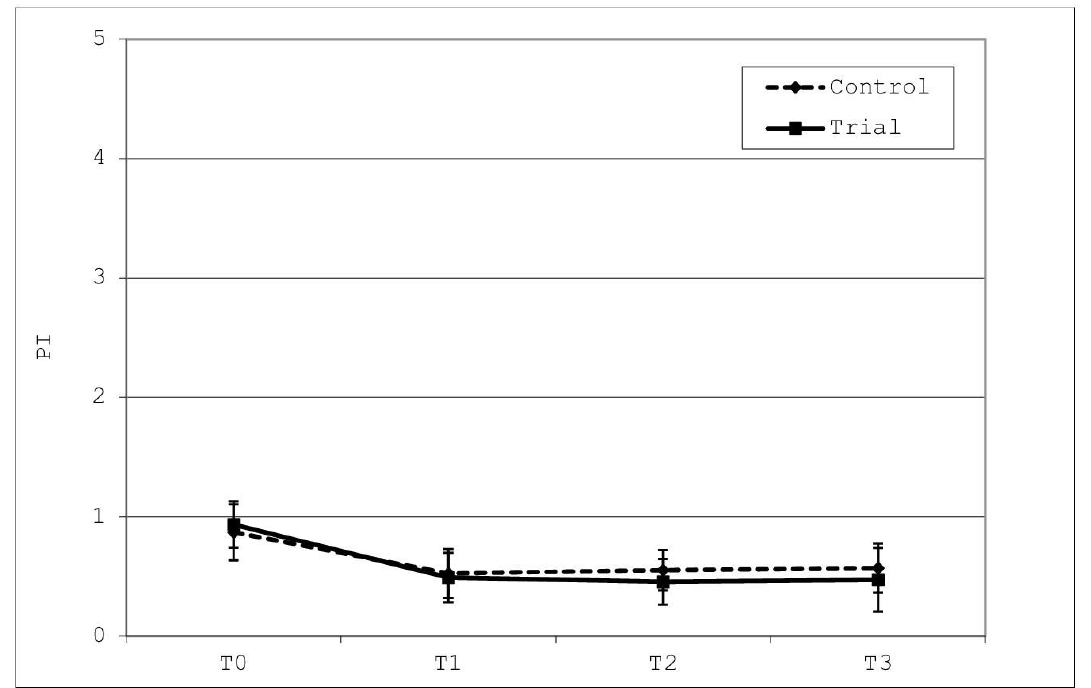
Figure 4. Plaque index (PI). Mean and standard deviation of the PI in the intervention and control group. Table 4. Descriptive statistics of PI results.